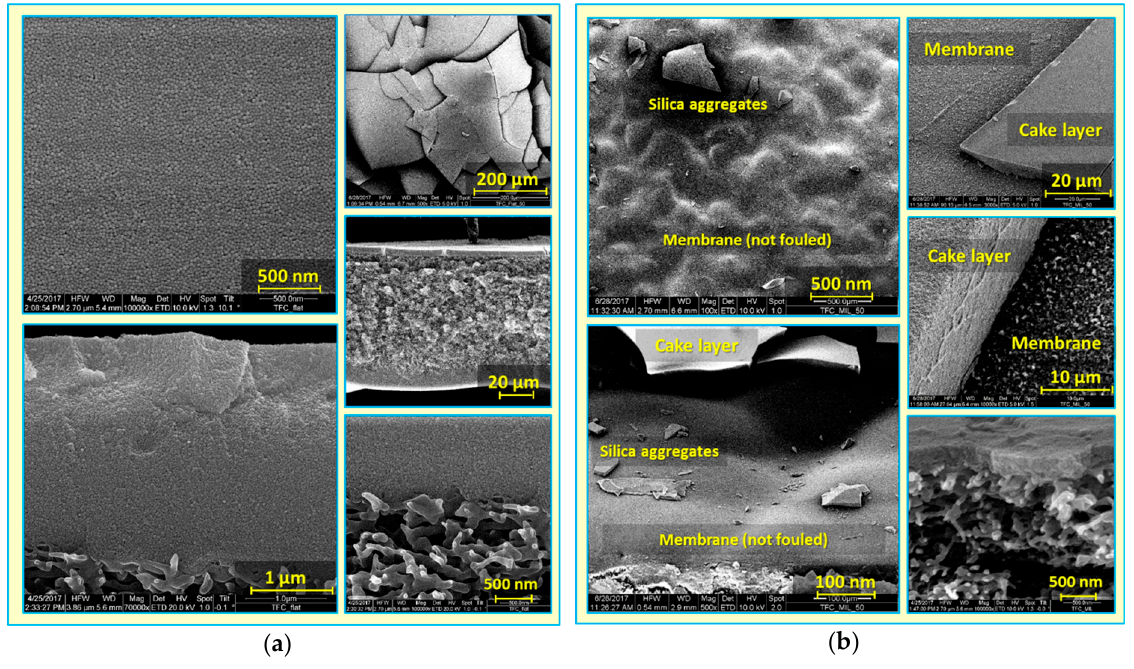
Figure 7. SEM micrographs at different magnifications for colloidal silica fouling of flat ( a ) and micro-patterned ( b ) pristine PA TFC membranes using silica nanoparticles (50 nm) in unstirred dead-end filtration conditions.